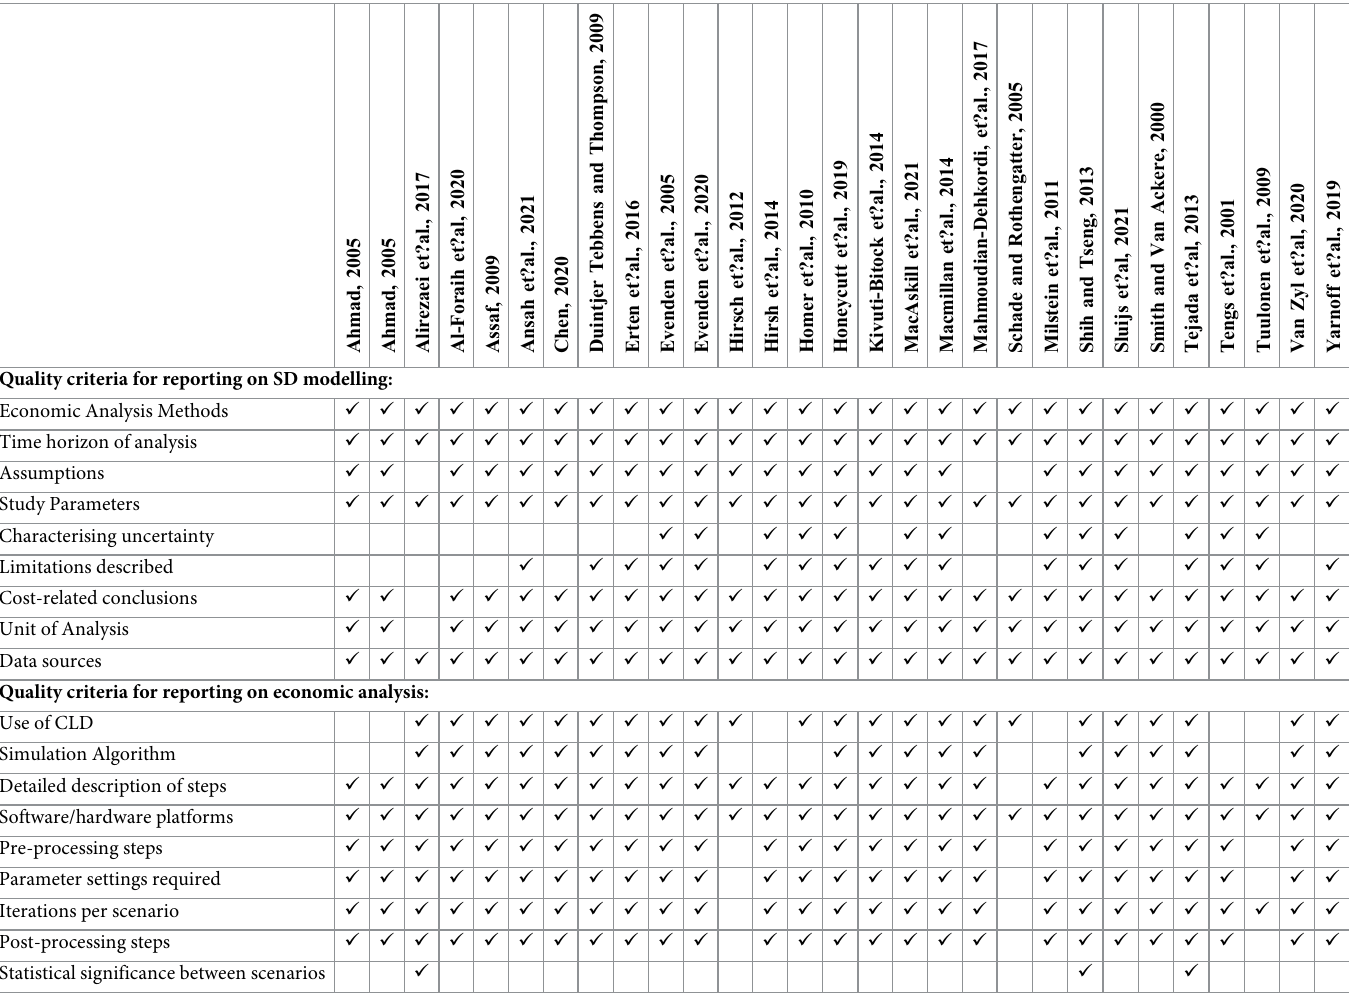
Parameter settings